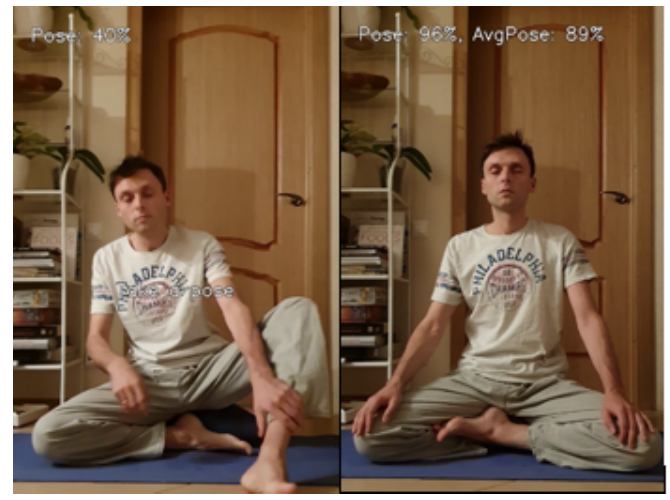
Figure 18. Examples of meditation pose recognition based on a developed model.